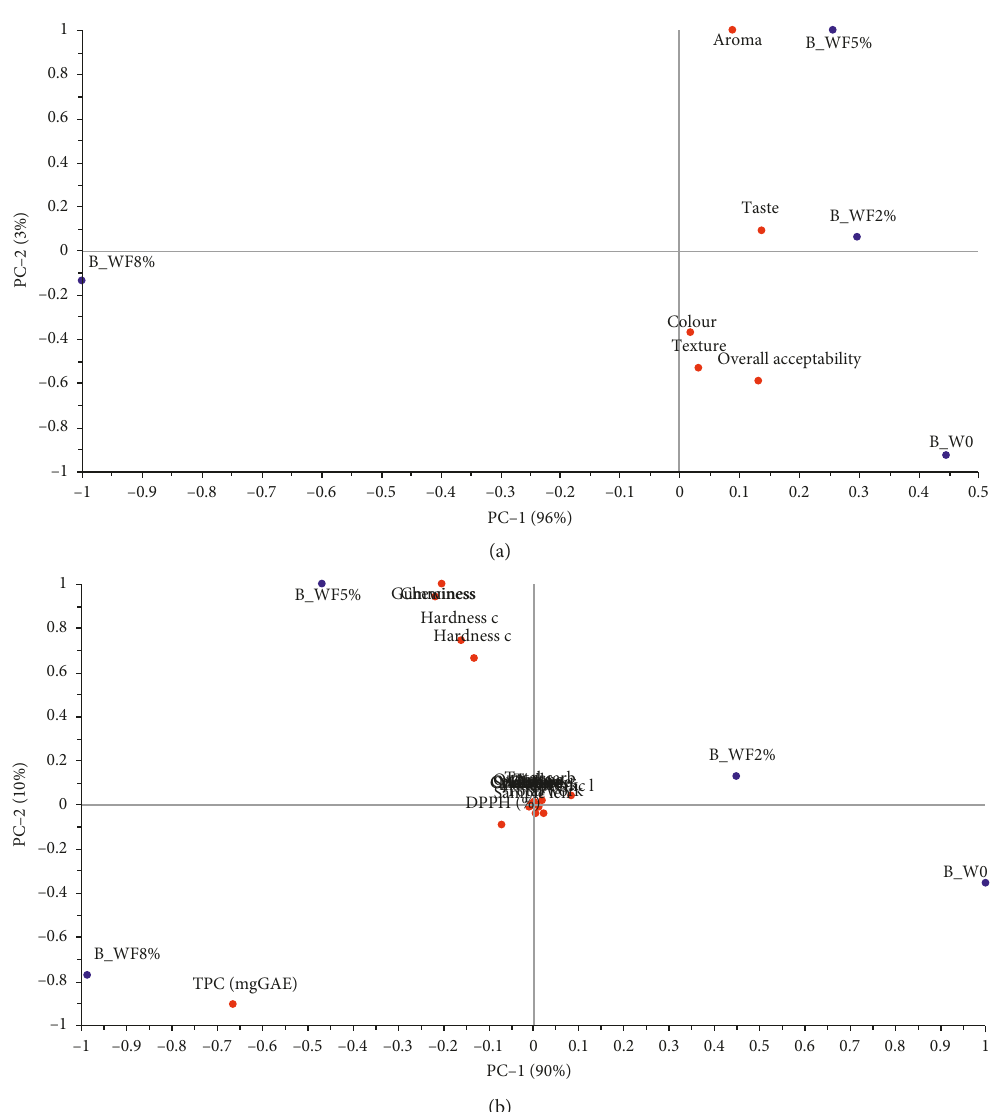
Figure 2: Principal component analysis biplots for wheat-fenugreek bread samples as compared to a control dark wheat bread: (a) sensory characteristics; (b) all physicochemical, textural, and sensory parameters (Tables 2–4). Figure 2(b) is shown in the Supplementary Materials section without overlapping as Figures S2b and S2c (center zoom). B_WO flour+2% fenugreek flour; B_WF5%